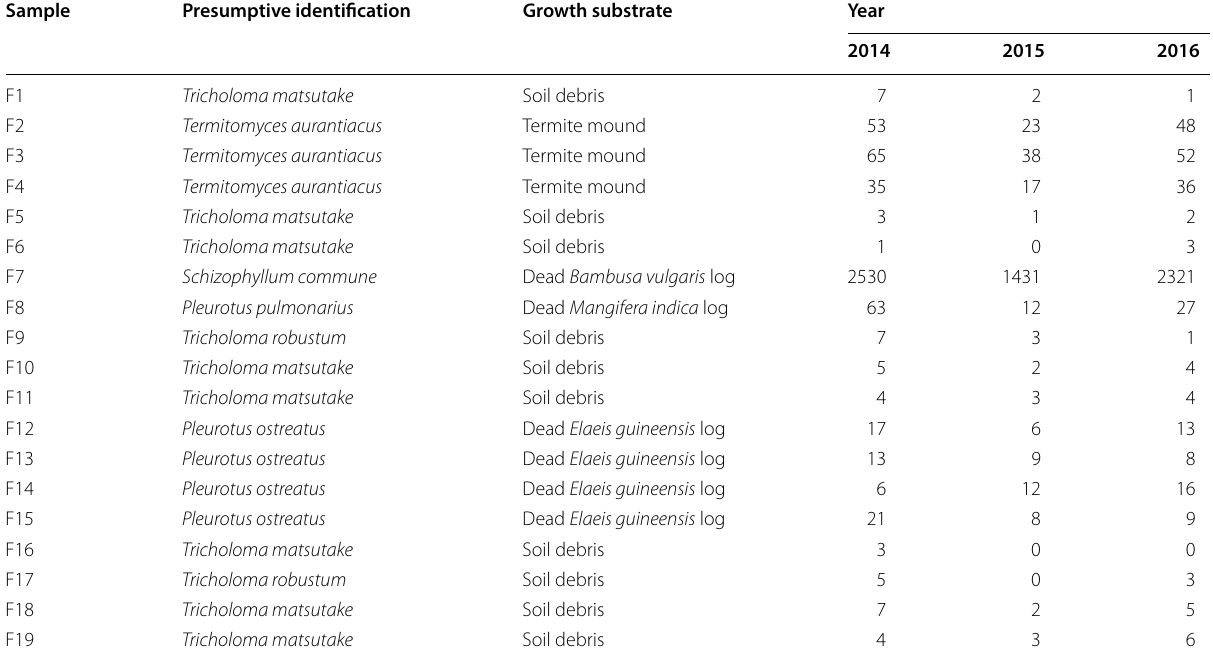
Table 1 Growth substrates and counts of wild mushrooms